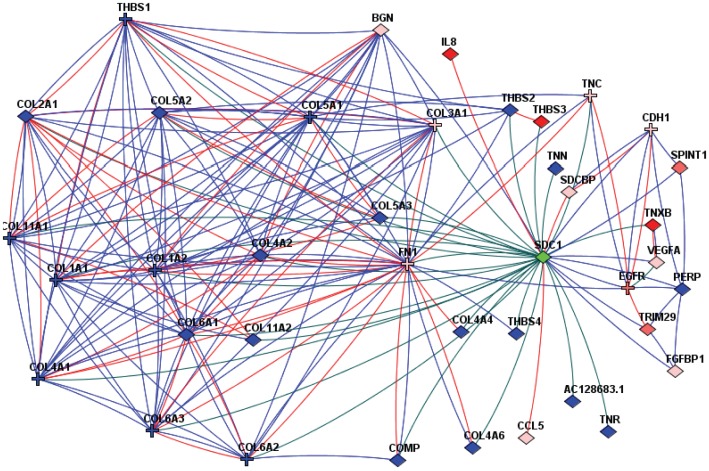
Most highly altered genes and their functional coupling to syndecan-1 according to the FunCoup network.The network view and layout was generated using the interface of FunCoup web site http://funcoup.sbc.su.se/. Red filled symbols denote genes in top 100 differentially expressed lists; pink symbols denote genes in top 900 differentially expressed lists. Blue filled symbols indicate other interactors of syndecan-1 in the analyzed network, beyond differentially expressed lists. Crosses correspond to genes with reported somatic point mutations by The Cancer Genome Atlas dataset (TCGA, 2008) [108]. Interactions are shown by lines: red lines = physical protein−protein interactions; blue lines = links established via co-expression in multiple datasets; green lines = links from KEGG pathways.